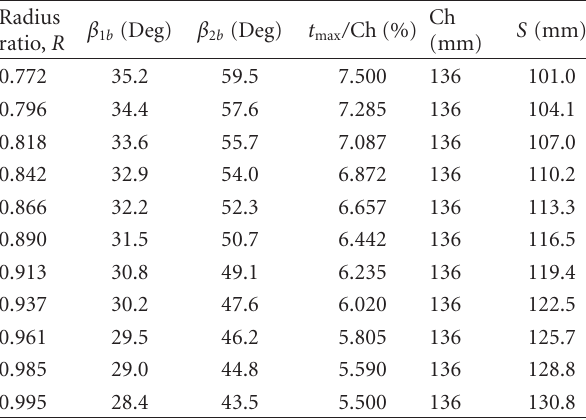
Table 2: Details of rotor blades.